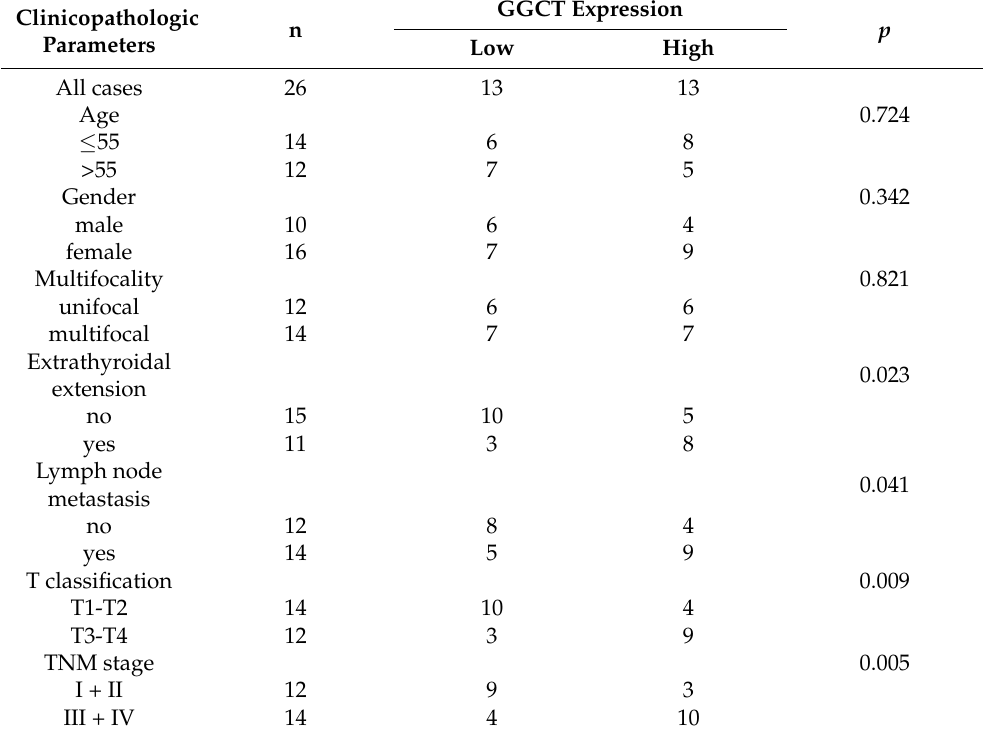
Table 1. Relationship between MRPL9 expression and clinicopathological characteristics in 26 PTC